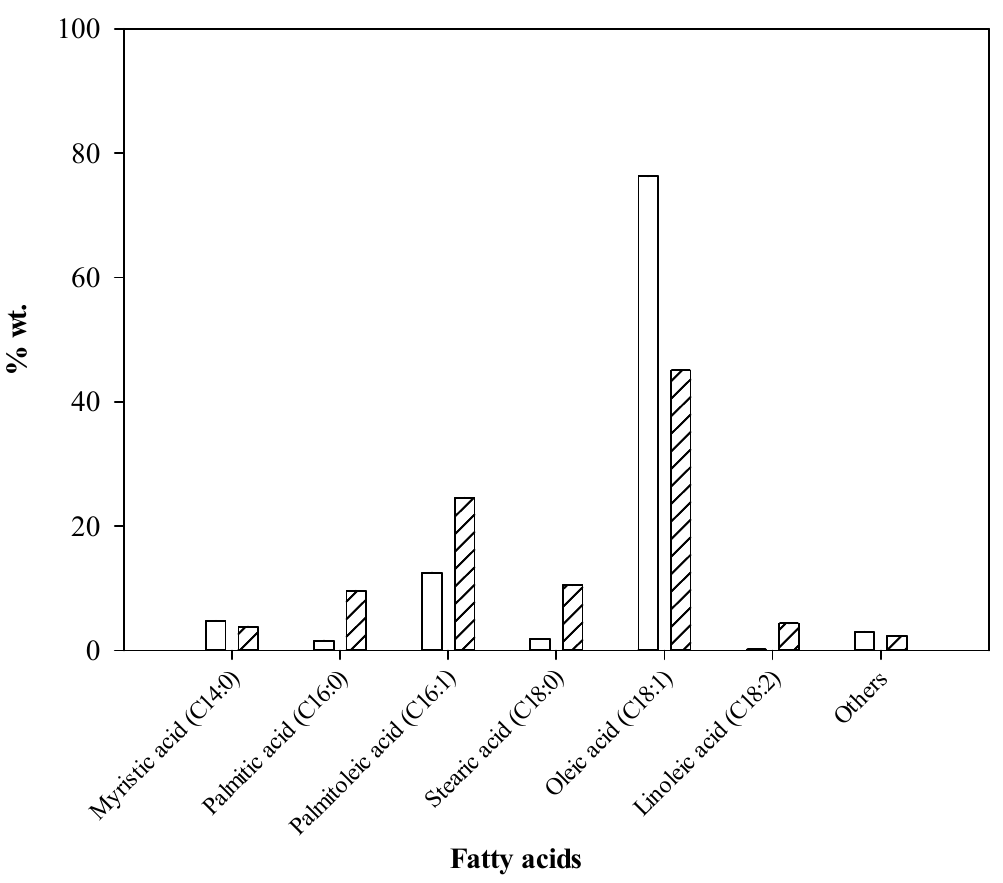
Figure 5. Comparison of fatty acid methyl esters (FAME) found in CPO/RPO biodiesel as a function of weight (%) (CPO FAME, RPO FAME).